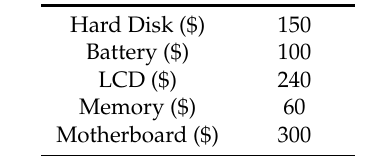
Table A5. Subassembly and component replacement costs for maintenance.